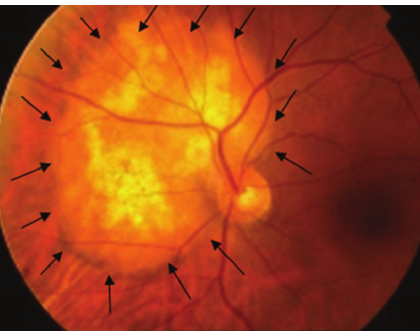
Figure 4: Fundus photo showed a decrease in the height of the choroidal lesion after 4 cycles of chemotherapy and intravenous bevacizumab.